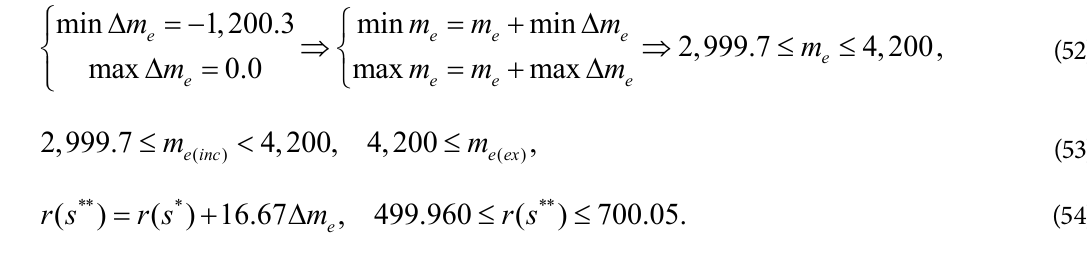
Table A10. Changes in restrictions on human assets of health and medical tourism destinations in the final iteration of programming Basic variables